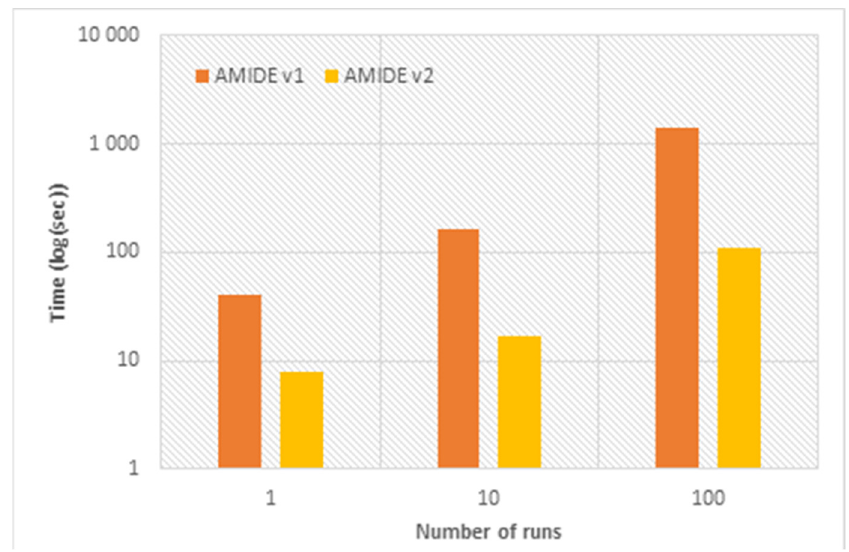
Figure 2. Performance comparison between the two AMIDE versions and depending on the number of docking runs. A log scale is used on the y -axis.